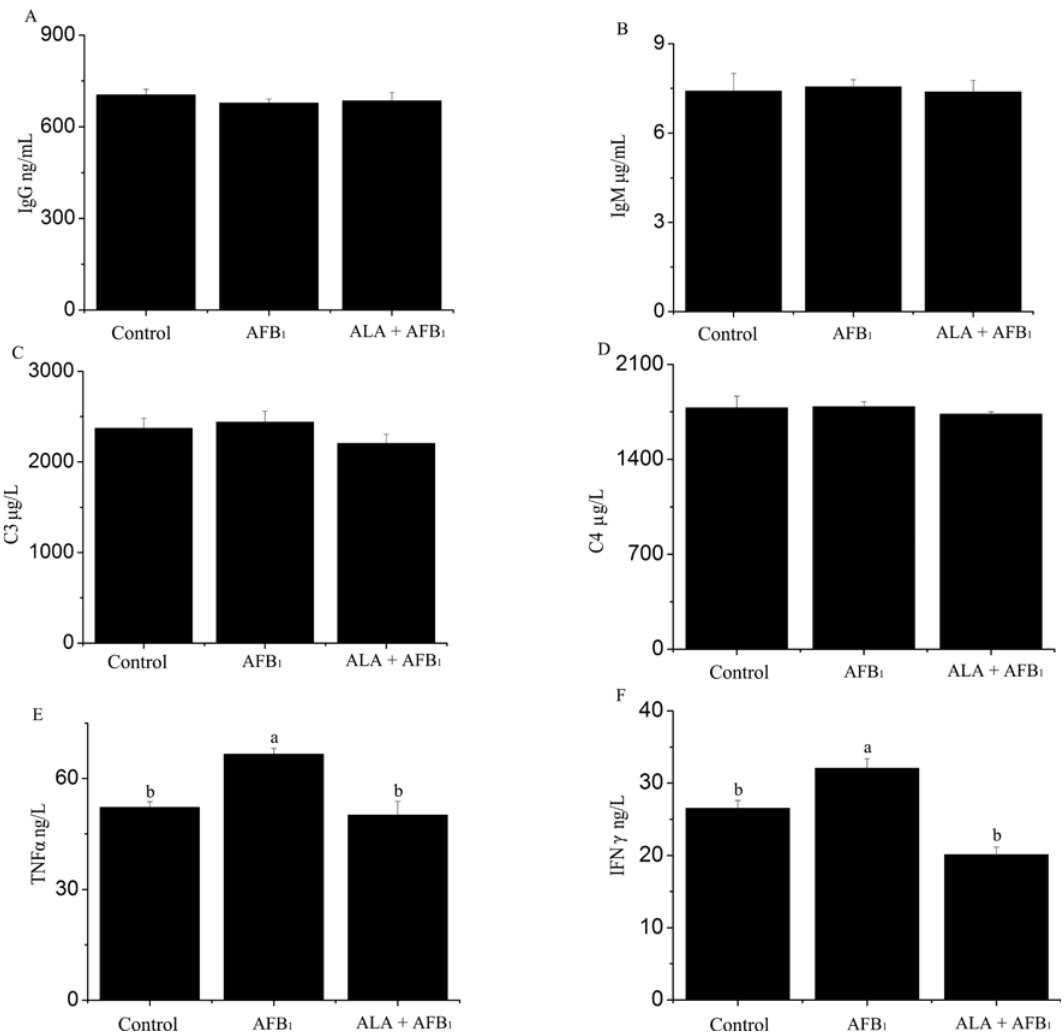
Figure 2. Effect of alpha-lipoic acid on serum immune response in broilers fed a diet containing aflatoxin B (AFB ). Humoral immunity: ( A ) IgG (immunoglobulin G); 1 1 ( B ) IgM (immunoglobulin M); ( C ) C3 (complement 3); and ( D ) C4 (complement 4); Cytokines: ( E ) TNFα (tumor necrosis factor alpha) and ( F ) IFNγ (interferon gamma). ( n =